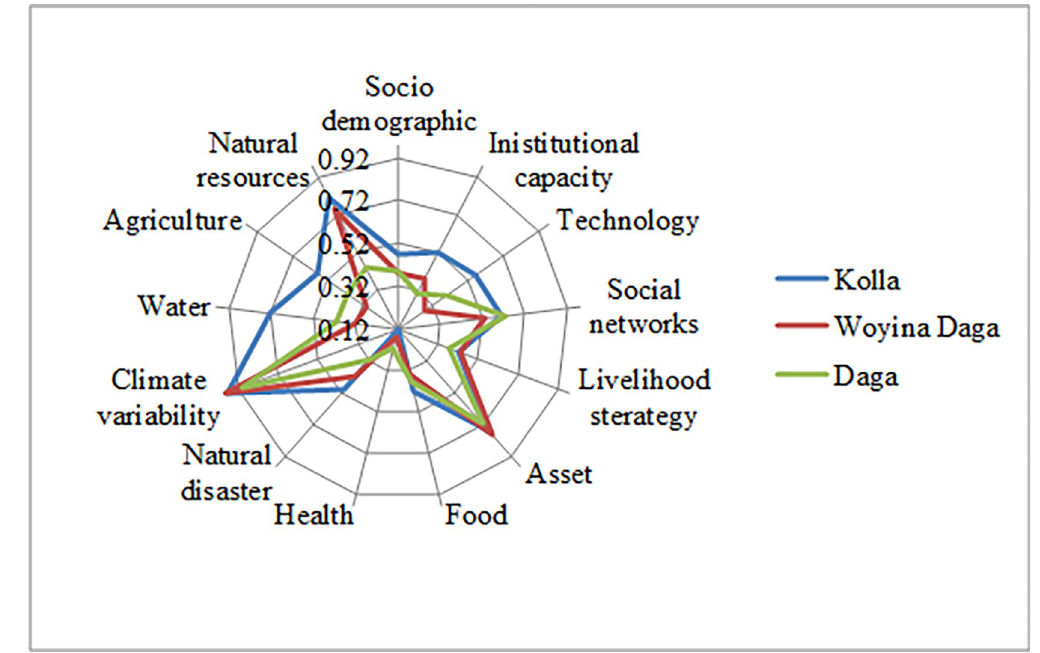
Fig 2. Vulnerability Spider Diagram of the major components of the Livelihood Vulnerability Index (LVI) for the study area.